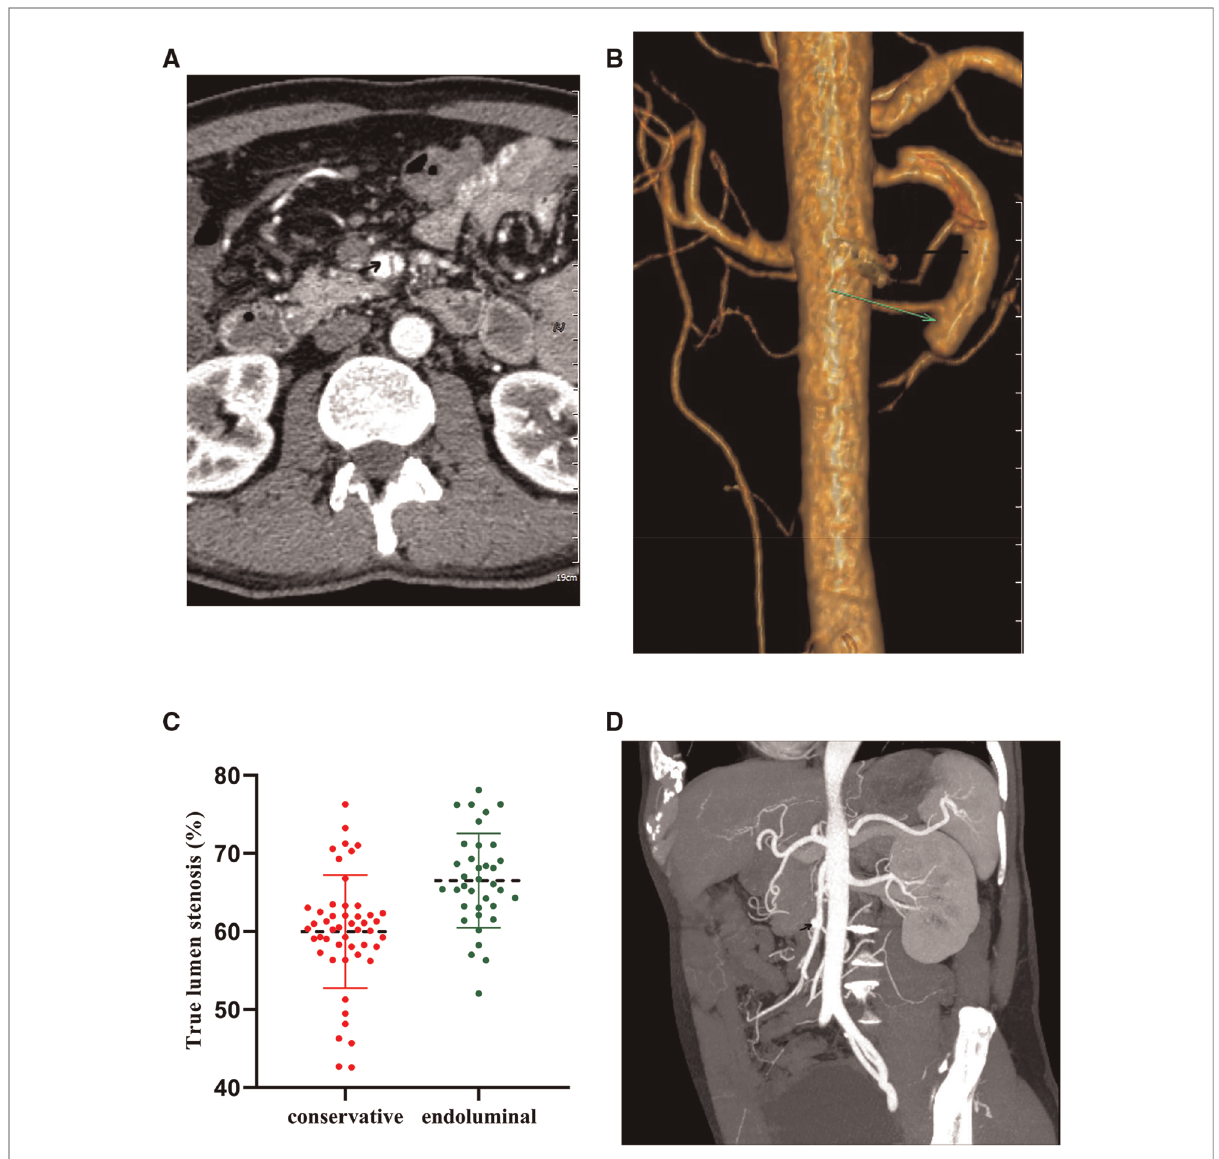
FIGURE 1 Diagnostic abdominal CTA. ( A,B ) Typical cases of the endoluminal treatment group. ( C,D ) Typical cases of the conservative treatment